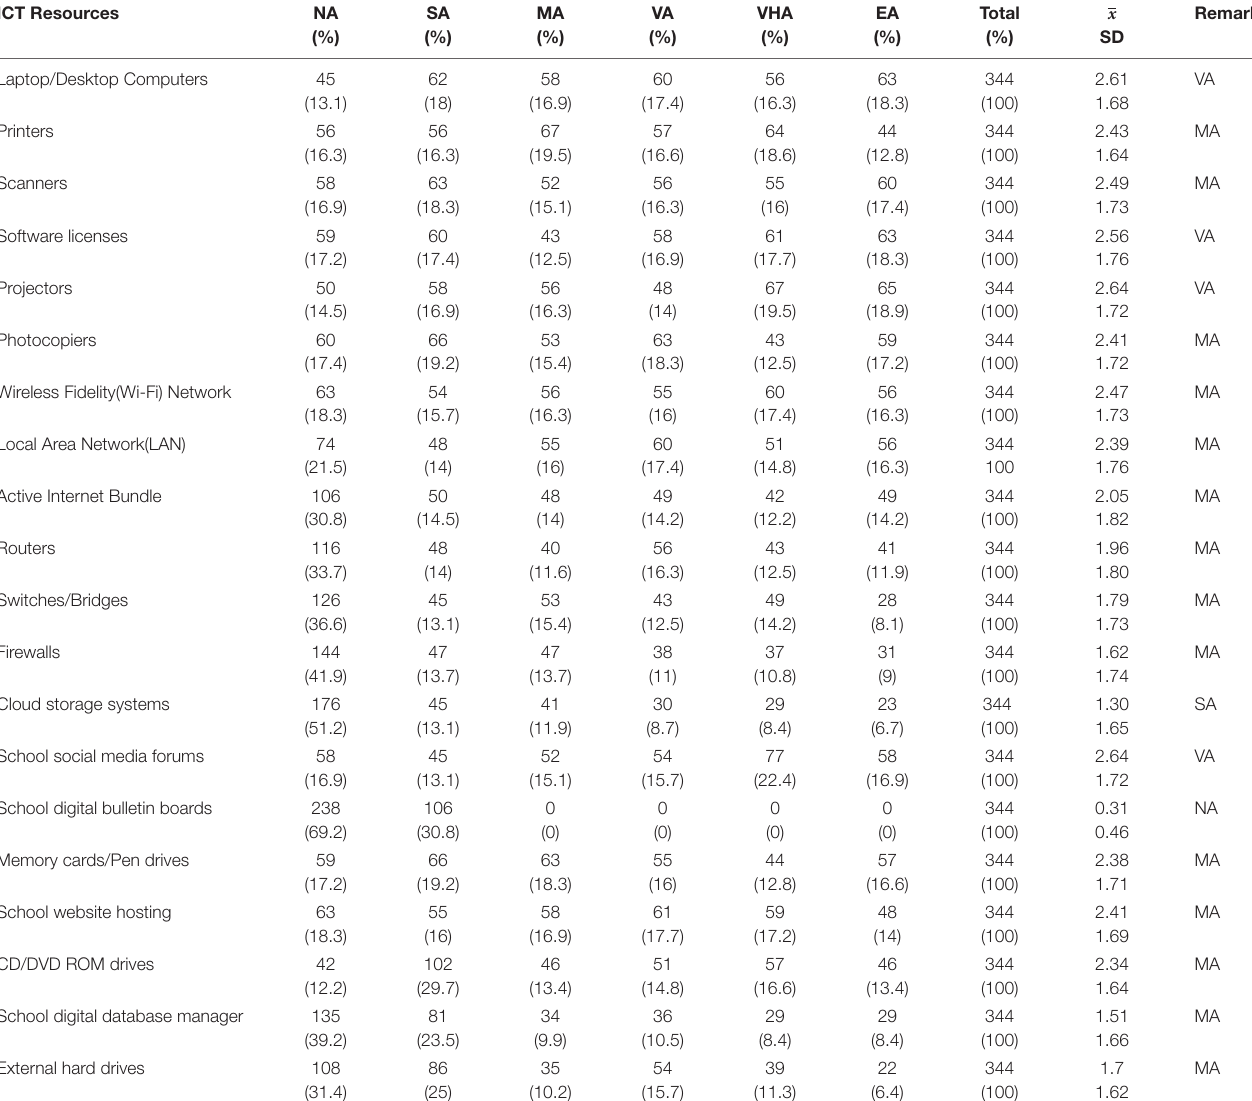
TABLE 2 | Frequency distribution showing the availability of ICT resources in public Universities during the COVID-19 pandemic. ICT